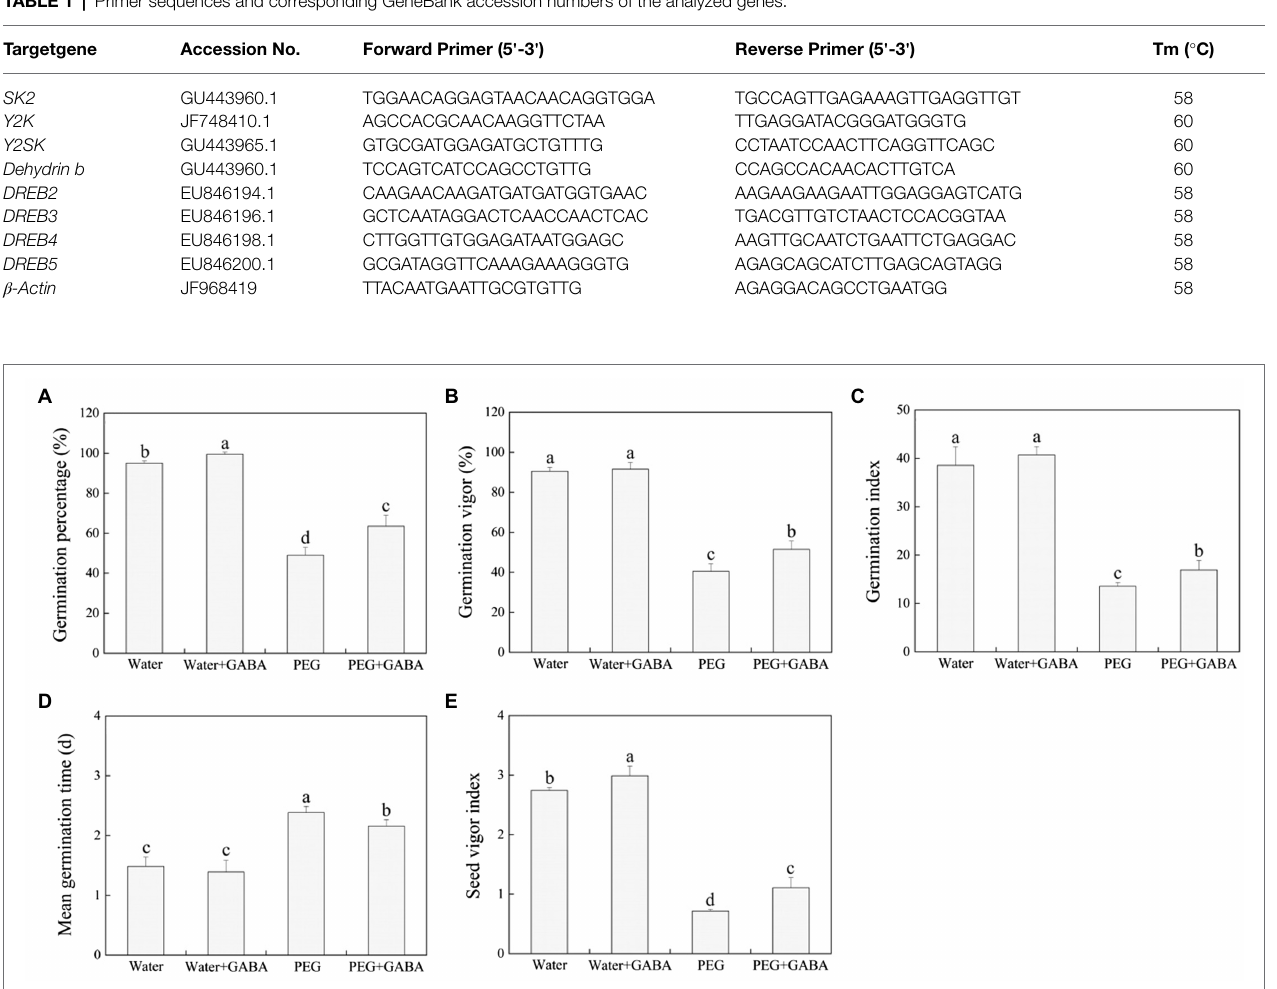
FIGURE 1 | Effects of seed priming with deionized water or γ -aminobutyric acid (GABA) on germination characteristics [ (A) germination percentage (GP), (B) germination vigor (GV), (C) germination index (GI), (D) mean germination time (MGT), and (E) seed vigor index (SVI)] of white clover seeds under water